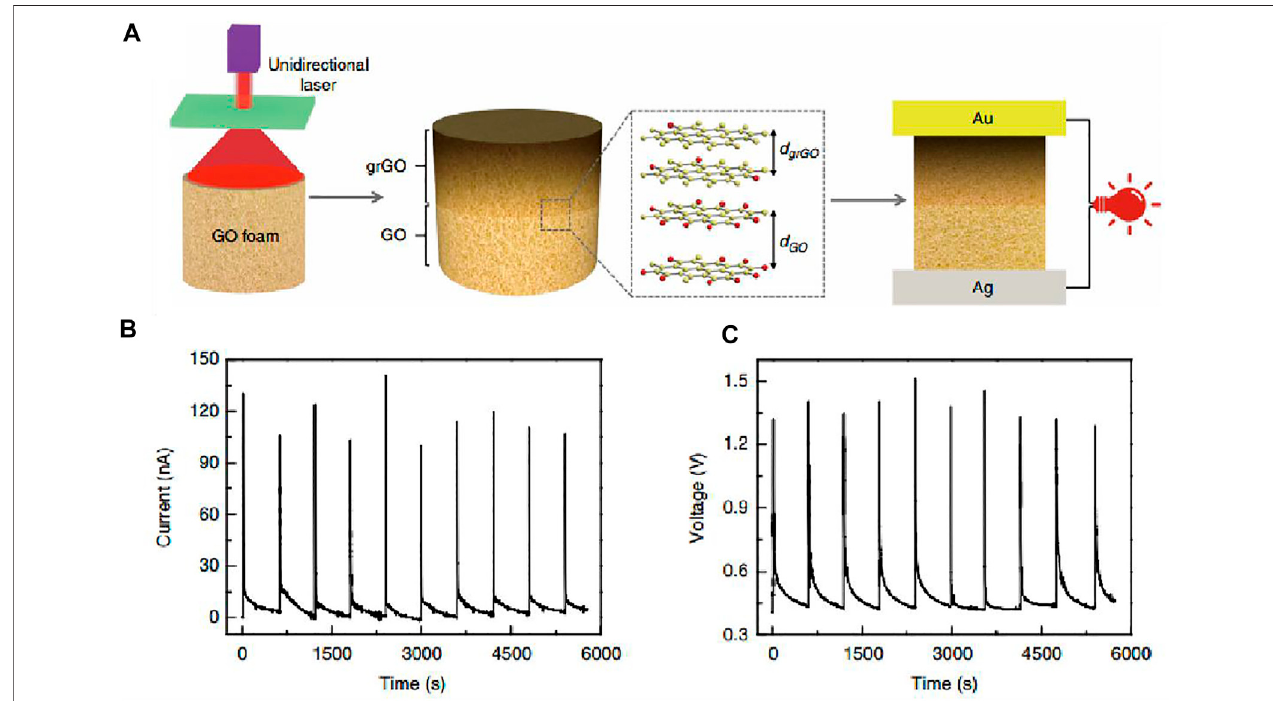
FIGURE5|(A) SchematicillustrationoftheprocessofheterogeneousGO-basedhygroelectricgeneratorpreparation.First,theporousGOfoamwaspreparedby freeze-dryingmethod;then,thematerialwasreducedusingaunidirectionallaser.Theresulting3D-GOconsistsofaGOlayerandalayerofreducedgrapheneoxidewith agradientdistributionoffunctionalgroupsandcompactinterlayerspacing. (B) Currentand (C) voltageoutputcycleperformancesofthehygroelectricgenerator(Figures reprinted from ref. 91 with permission. Copyright 2018; Nature Publishing